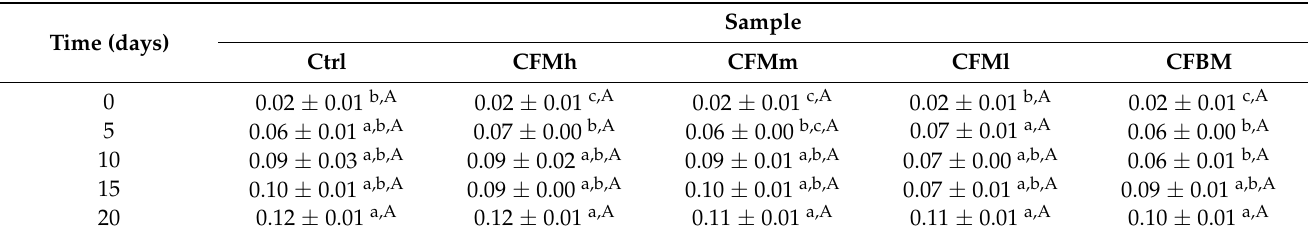
* Arithmetic mean from at least three repetitions ± standard error. Means connected by the same lowercase letters are not significantly different ( p ≥ 0.05) and indicate difference in the same treatment at different evaluation times. Means connected by the same uppercase letters are not significantly different ( p ≥ 0.05) and indicate differences between treatments at the same evaluation periods. Ctrl = Control sausage (not covered), CFMh = Sausage covered with high molecular weight chitosan films, CFMm = Sausage covered with